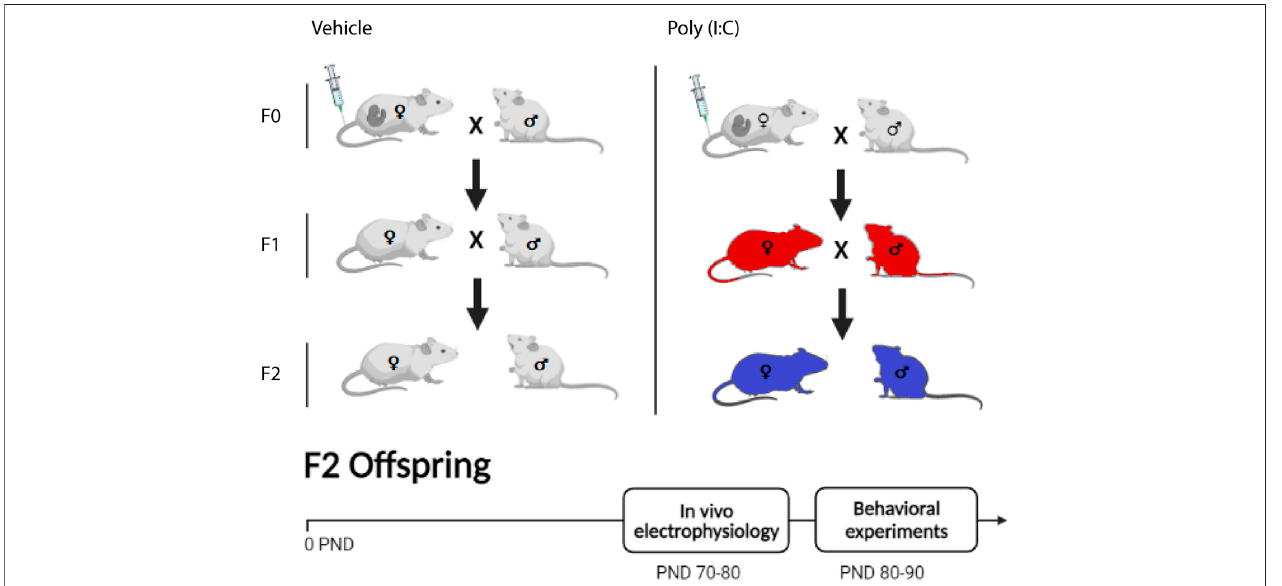
FIGURE 1 | Representation of the experimental protocol. Polyriboinosinic-polyribocytidilic acid [poly (I:C)] treatment during pregnancy of F0 dams consisted in a single i. v. injection of poly (I:C) (4 mg/kg) or vehicle (sterile pyrogen-free saline) at the15th gestational day (GD15). F1 and F2 dams were not treated. In white the F0 generation, treated with poly (I:C) or vehicle. The same color was used both for F1 and F2 that descended from vehicle-treated F0 generation. In red the F1 poly (I:C)- generation, direct descendants from the F0 poly (I:C) insult. In blue, the F2 poly (I:C)-generation, which descends from F1 non-treated generation. In vivo electrophysiology recordings were performed between postnatal days (PND) 70 and 80, whereas behavioral experiments between 80 and 90